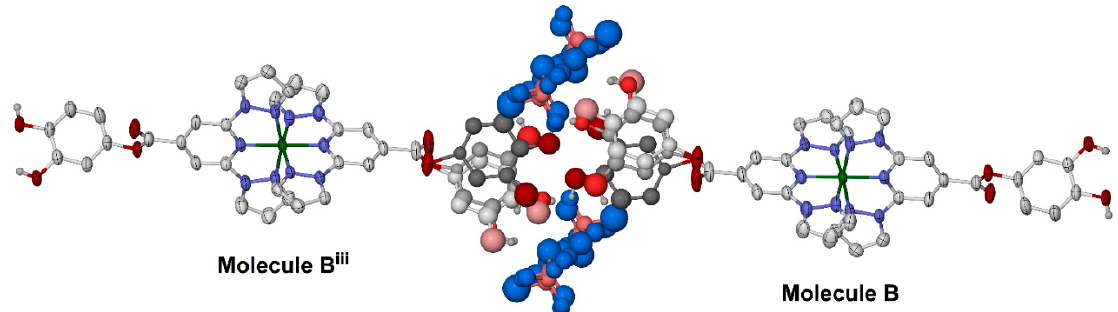
Figure 3. Ligand and anion disorder about a crystallographic inversion centre in molecule ‘B’ of [Fe( L 4 ) 2 ][BF 4 ] 2 . C-bound H atoms are omitted for clarity; other details as for Figure 1. The three disorder sites of the dihydroxyphenyl substituents are distinguished with pale, medium, and dark colouration. Symmetry code: (iii) ‒ x , 2 ‒ y , ‒ z . Colour code: C, white, pale or dark grey; H, pale grey; B, pink; F, cyan; Fe, green; N, blue; O, pale, medium, or dark red.